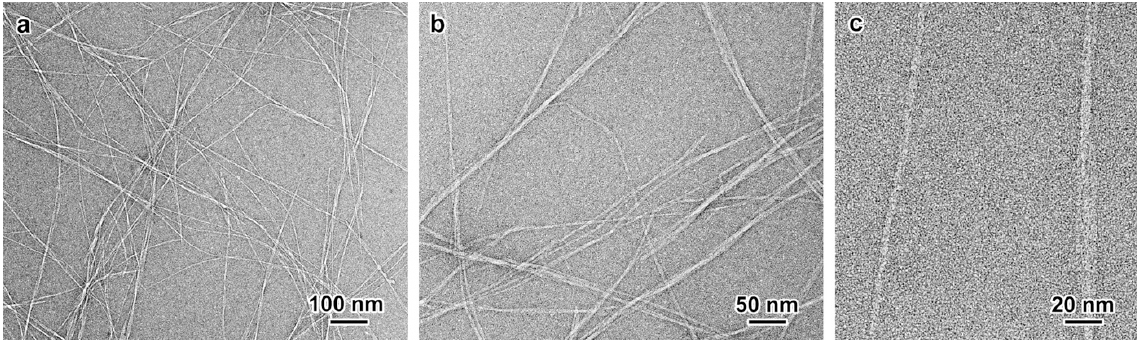
Figure 2. ( a–c ) TEM images of a negatively stained preparation of ivory nut nanocellulose extracted from the endosperm of crude parenchyma treated with 8 M H 2 SO 4 for 4 h at 30 ◦ C and ultrasonicated. The image in c shows an individual nanofibril (left) as well as a bundle of three (right).